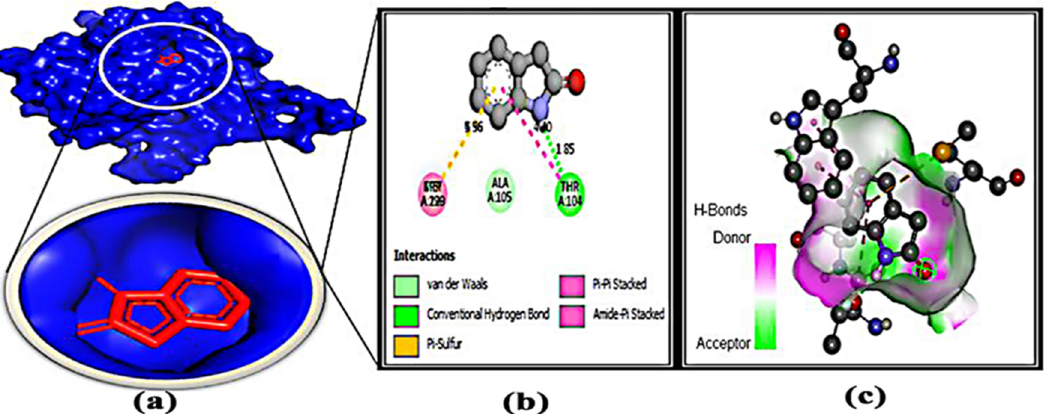
Figure 7. Docking simulation between protein–ligand interactions of nucleosidase (MTAN) enzymes and 2H-indol-2-one, 1,3-dihydro-, respectively, with ( a ) cartoon view (binding pocket), ( b ) 2D view, and ( c ) hydrogen bonding.